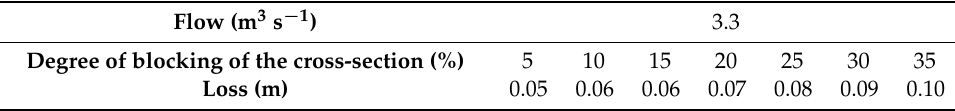
Table 5. Juxtaposition losses resulting from a decrease in the flow capacity of trash